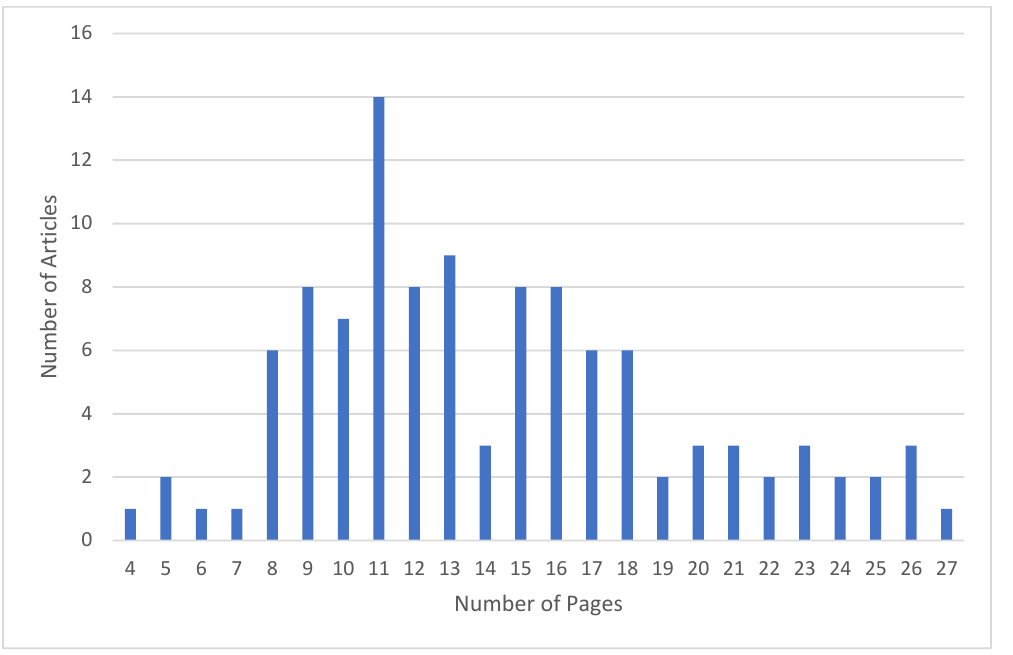
Figure 3. Distribution of DEA window analysis articles by the number of pages.